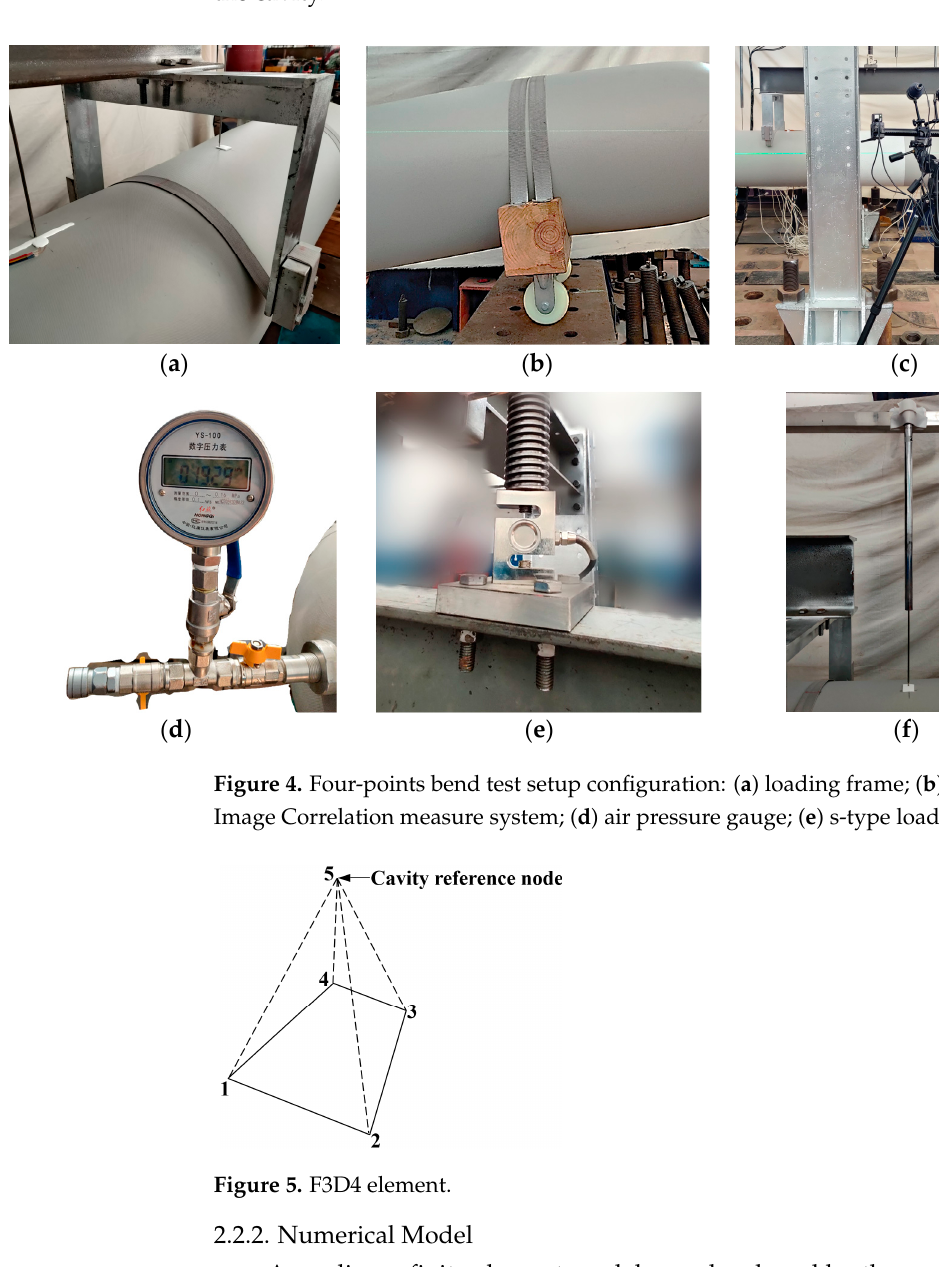
Figure 3. Four-points bend test setup diagram.